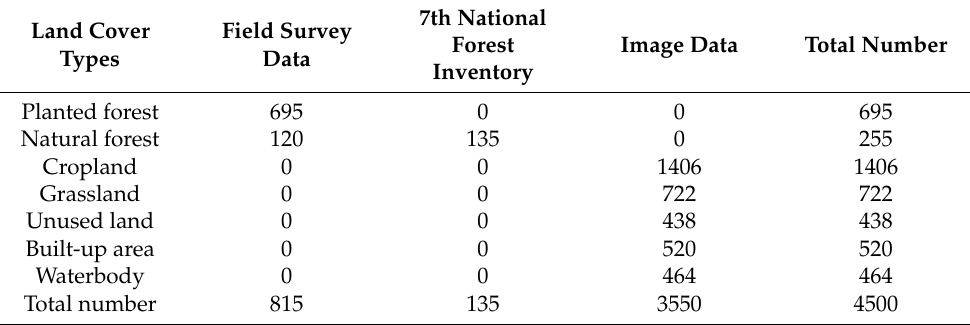
Table 1. Numbers of reference pixels and their sources for each land cover